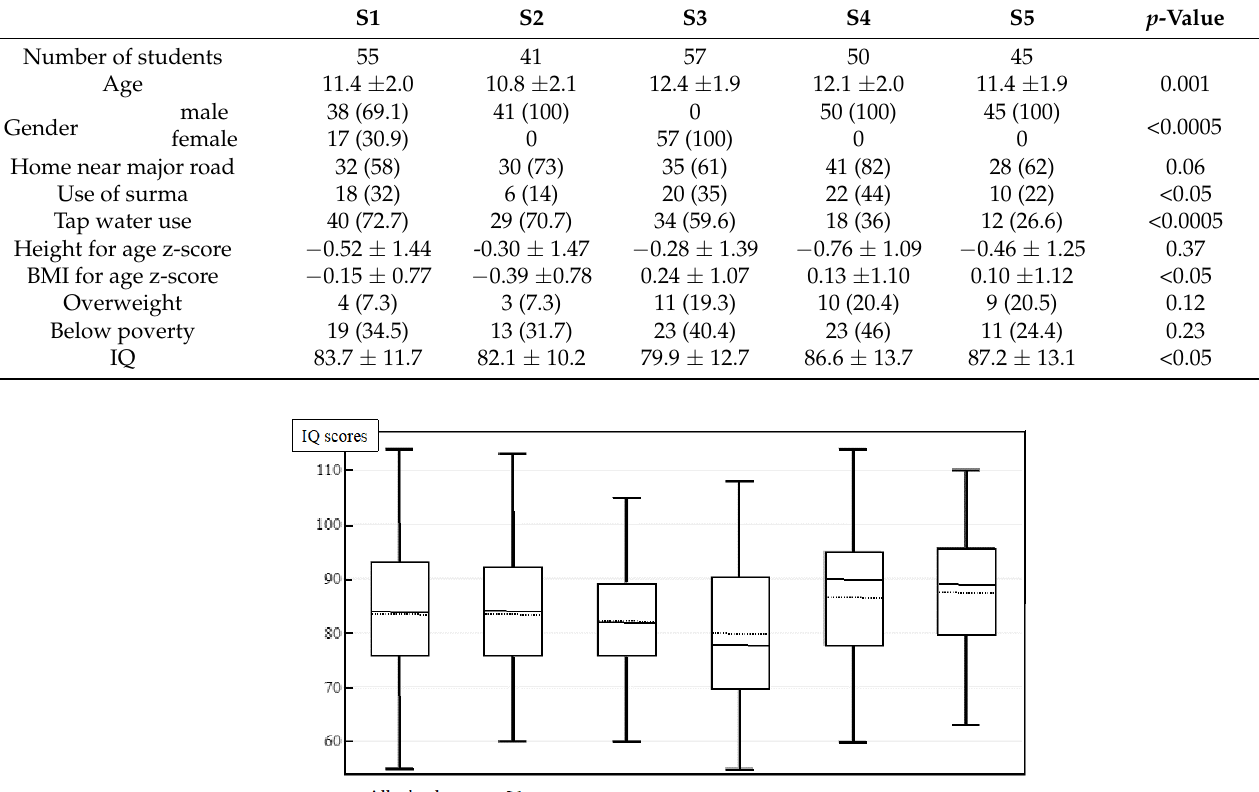
Table 1. Results from sample description with children’s predictors in each school. Data are means ±